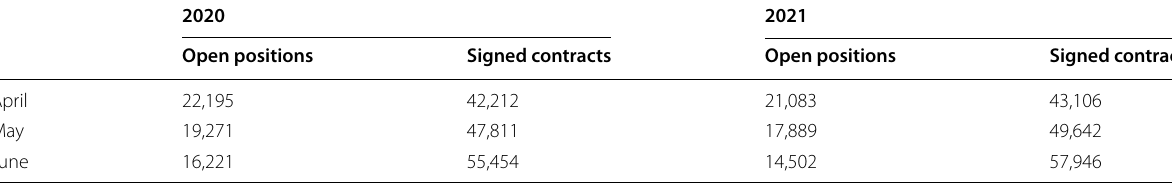
Table 1 Open apprenticeships (total) and signed contracts (cumulative), 2020 and 2021. Source : “Taskforce Perspektive Berufslehre 2020”. Numbers are recorded at the end of the respective month. The monthly changes in the number of vacancies and signed contracts are not equal, because the number of vacancies does not cover all vacancies, but only those posted on the national